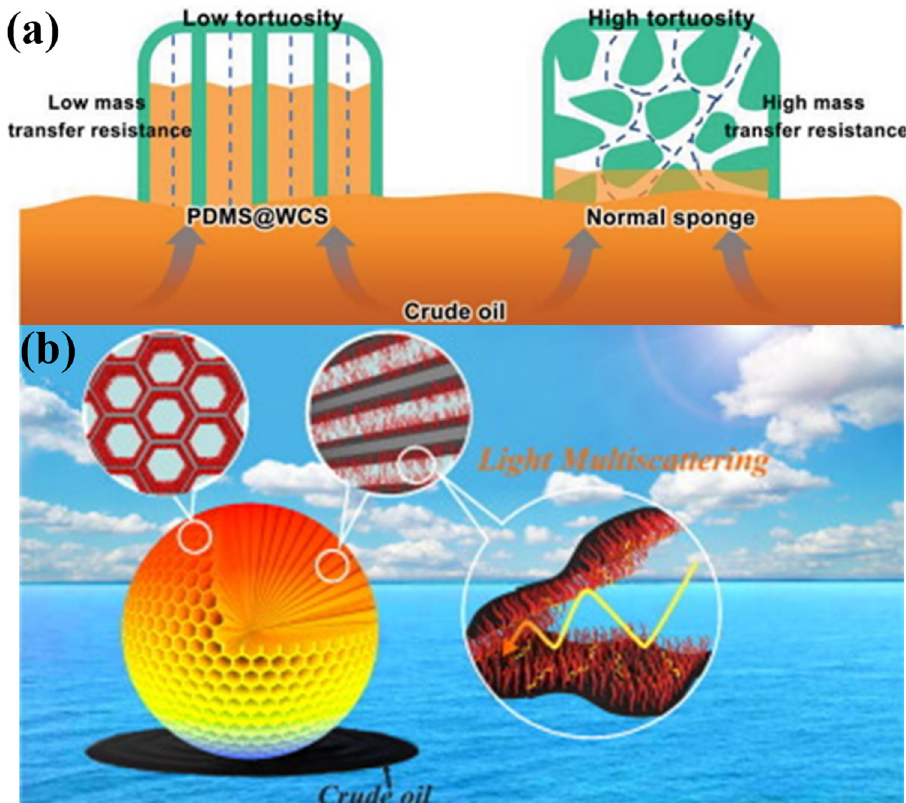
Figure 4: ( a ) Schematic comparison between PDMS@WCS with aligned channels and commercial MS with random pores [ 64 ] . ( b ) Schematic diagram of CNTs/RGO microspherical aerogels photothermal conversion crude oil adsorption CNTs/RGO microspherical aerogels [ 65 ]